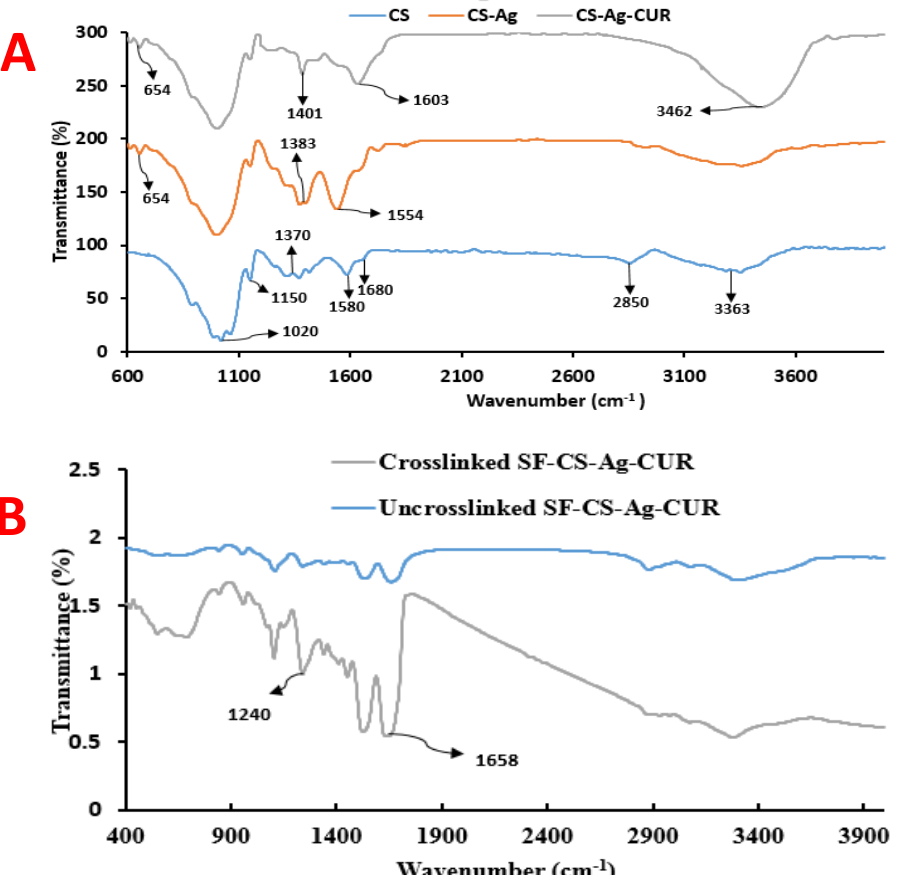
Figure 3. The FTIR spectra of ( A ) CS, CS-Ag, and CS-Ag-CUR ( B ) crosslinked SF-CS-Ag-CUR (CS 9% w / v ) and uncrosslinked SF-CS-Ag-CUR (CS 9% w / v ) nanofibers.